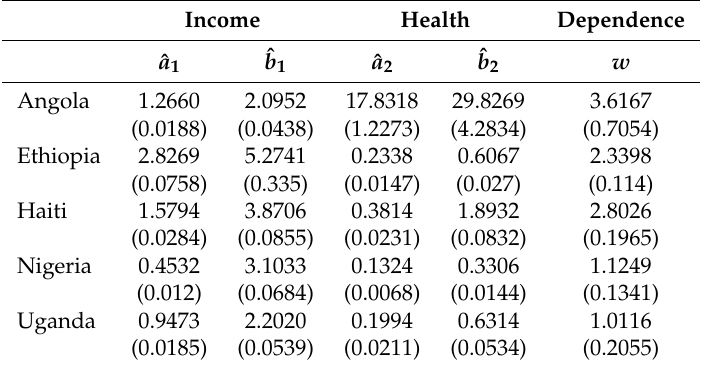
Table 1. Parameter estimates for the Sarmanov–Lee distribution with classical beta marginals (Equations (24)–(26)). Bootstrap standard errors in